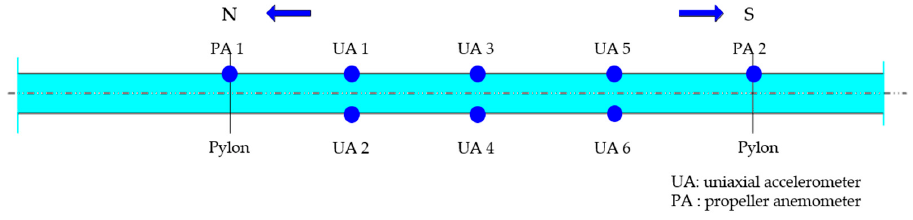
Figure 13. Location of anemometers.